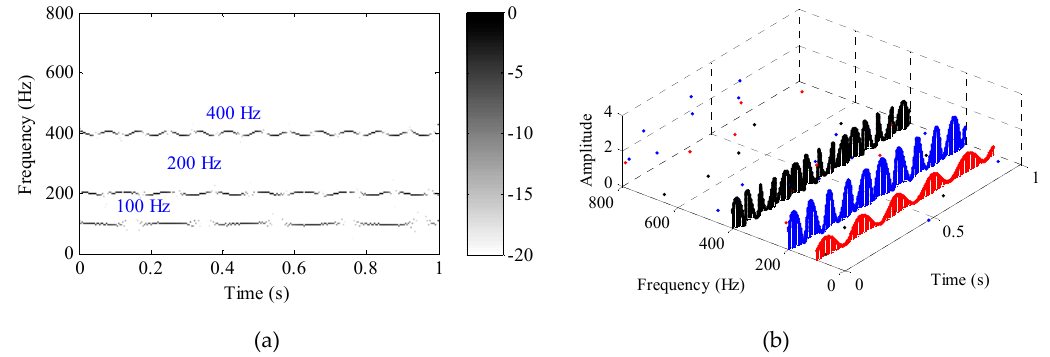
Figure 15. The time-frequency representations obtained by IAVMD for simulation 2: ( a ) Two-dimensional